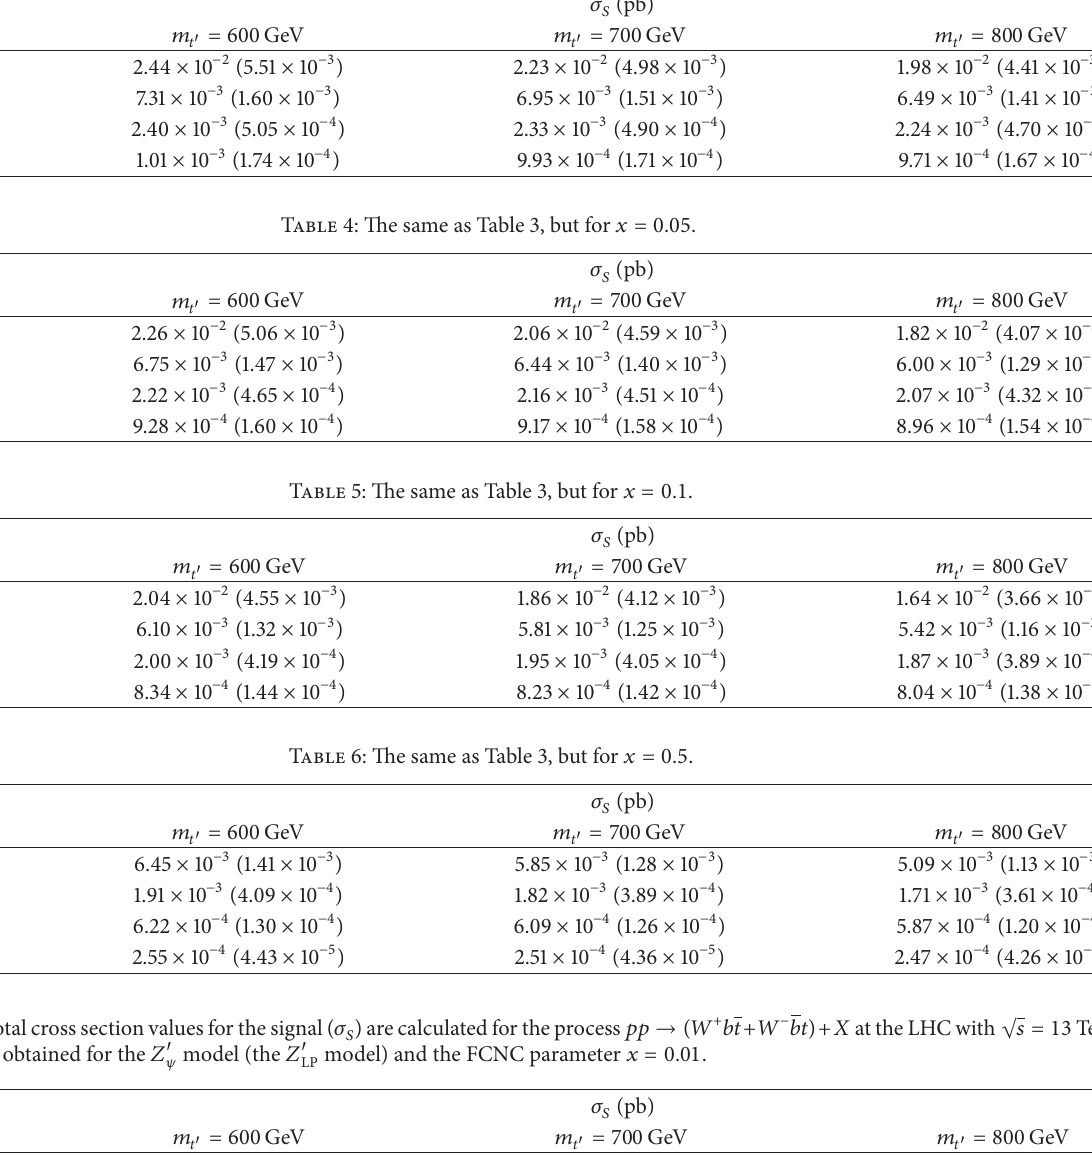
𝑍 󸀠 𝜂 model (the 𝜒 model) with the FCNC parameter